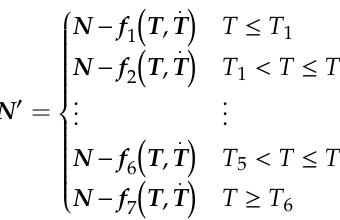
Figure 6. The single-axis RINS installed on the turntable.